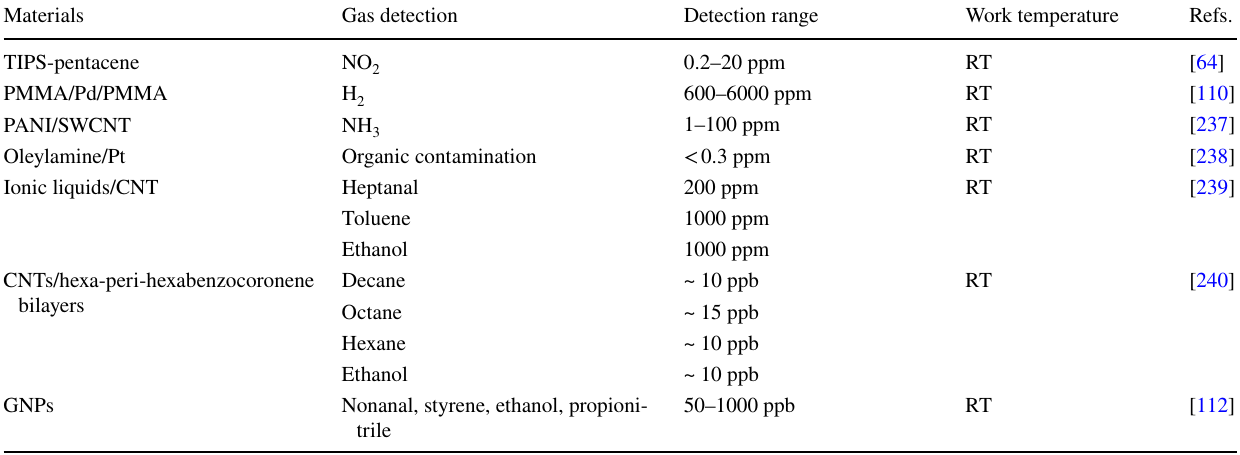
Table 3 Representative works based on regulation of charge transport